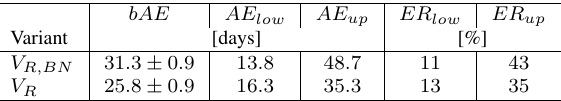
Table 6. Performance of the regression models on the test set.